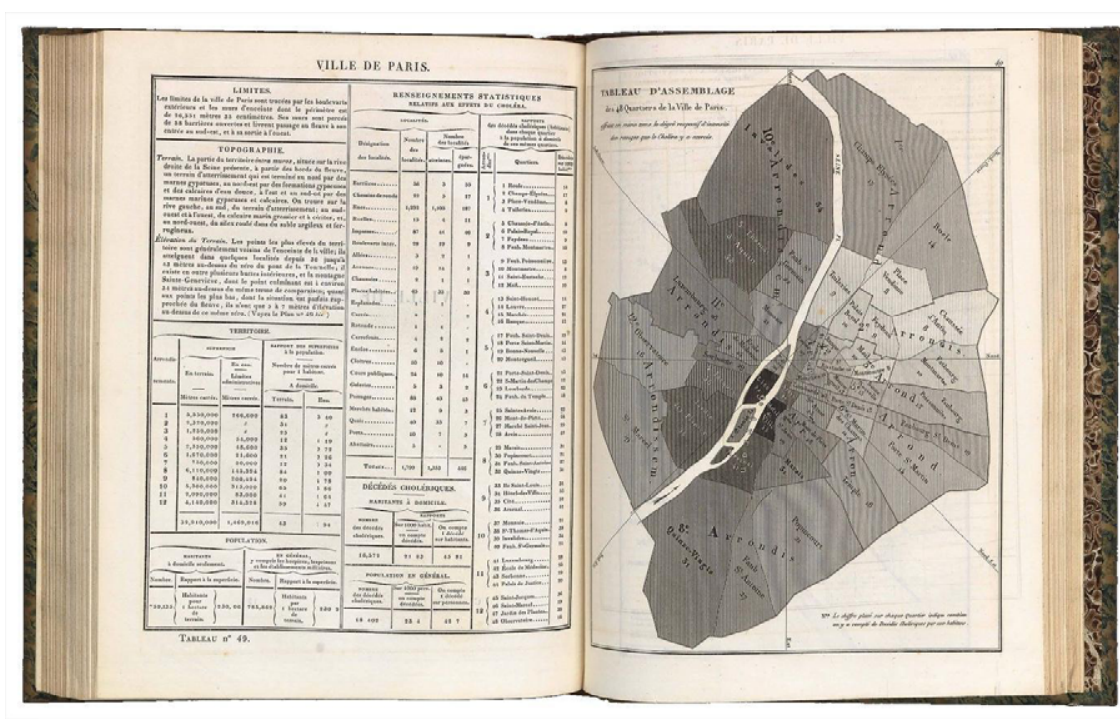
FIG. 2 The first epidemiological map regarding cholera effects in Paris by Louis- François Benoiston de Châteauneuf and Charles Picquet, July 1834. Source: Daniel Crouch rare books,